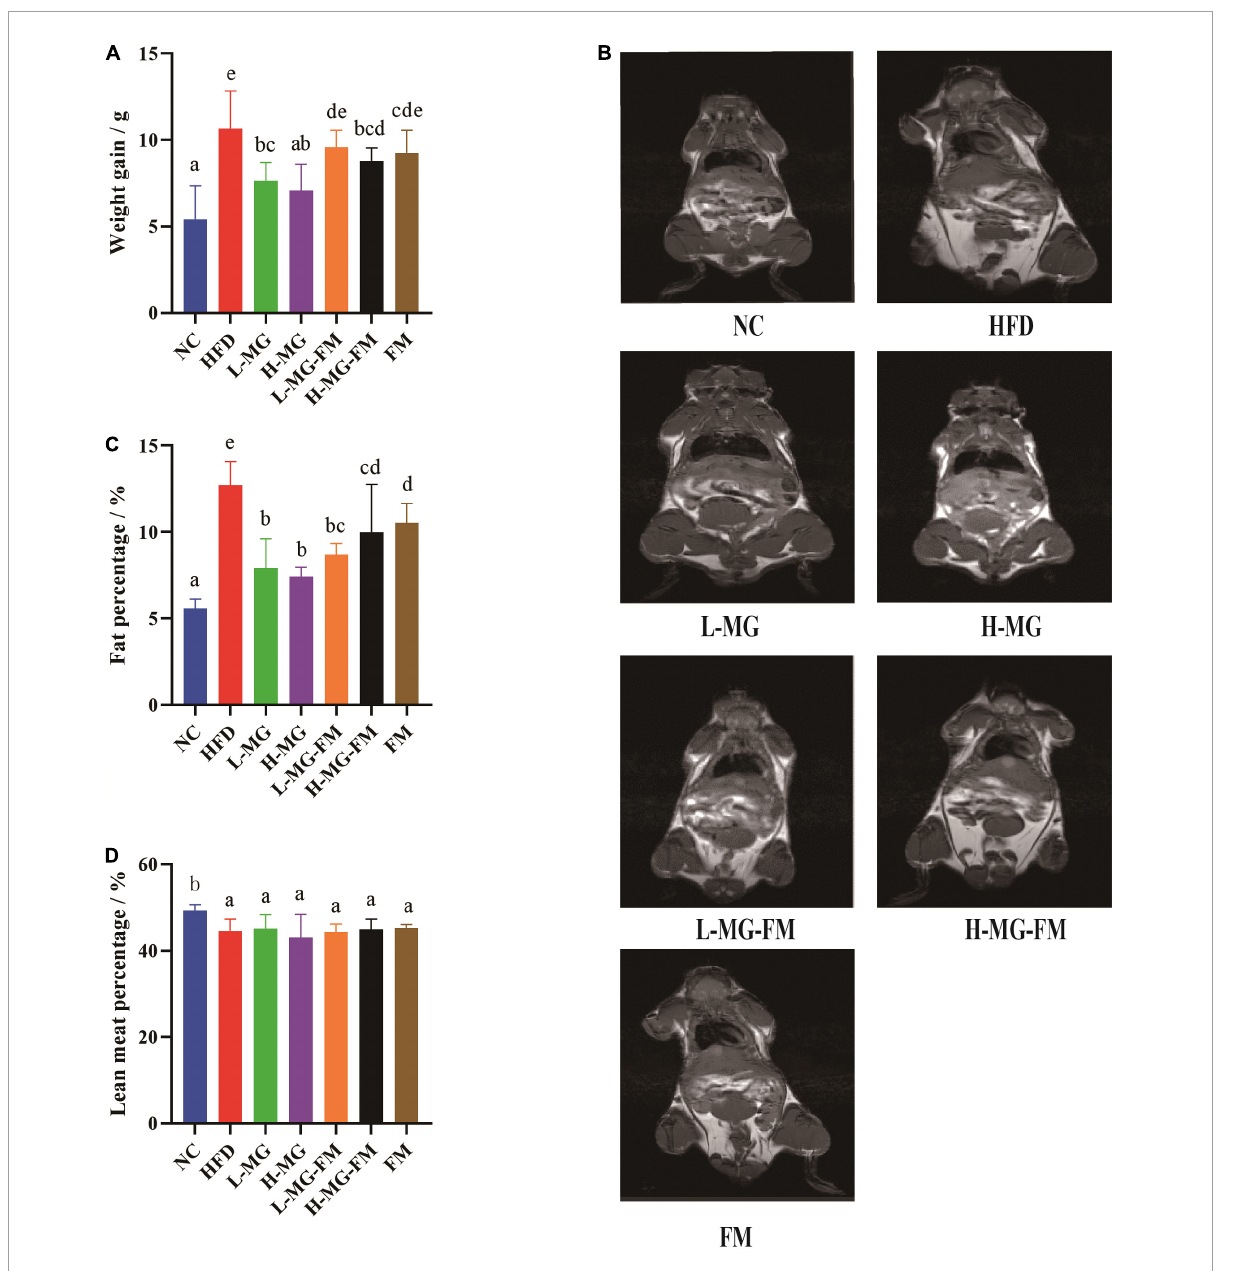
FIGURE1 Protective effects of MN-Gup against HFD-induced obesity in mice. (A) Body weight gain of mice; (B) typical nuclear magnetic resonance images showing fat mass; (C) fat percentage in mice; (D) lean meat percentage in mice. Different letters indicate significant differences in mice ( p < 0.05, n =